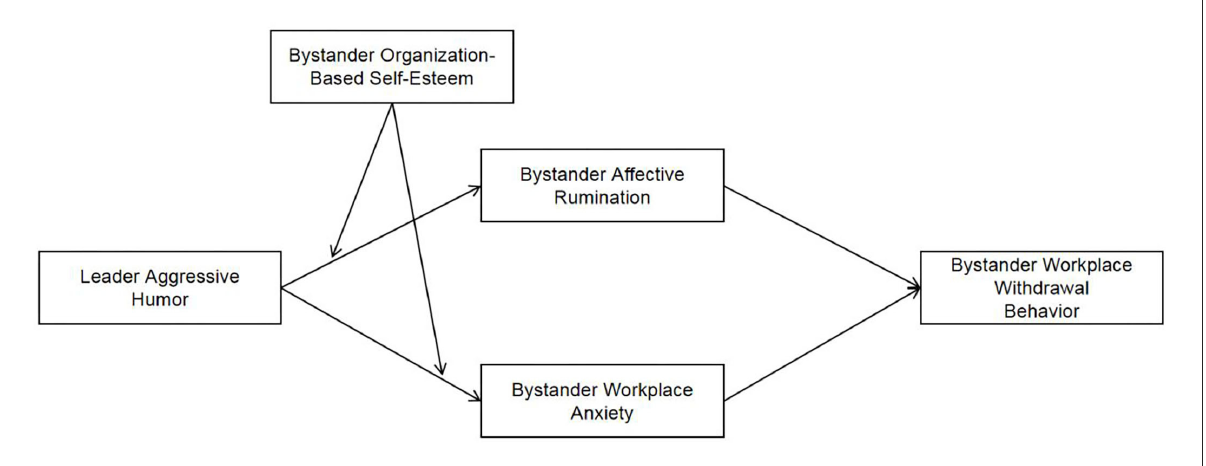
FIGURE1 Theoretical hypothesis